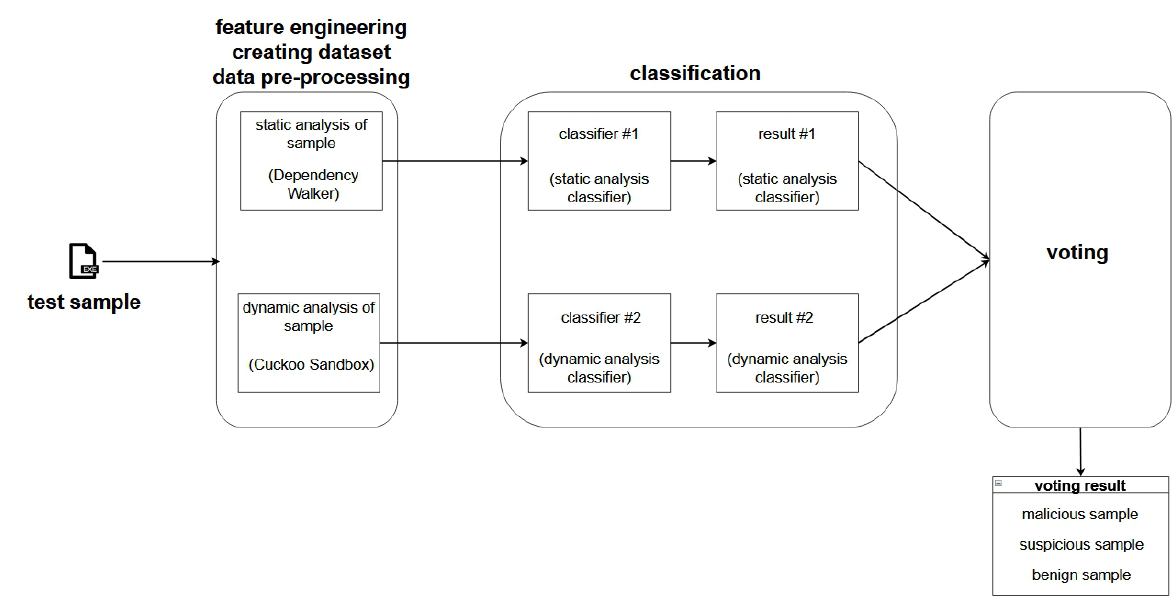
Figure 7. The proposed detection